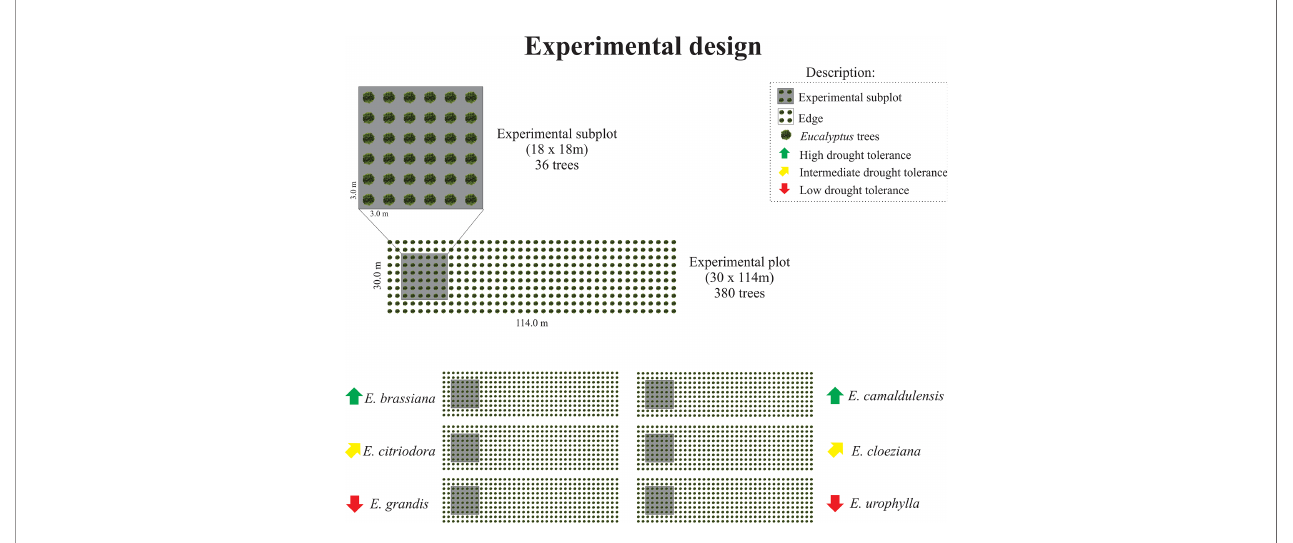
FIGURE 1 | Experimental design showing the plots and subplots in the fi eld considering the different Eucalyptus species according to the drought tolerance classi fi cation found in Gonc ̧ alves et al.